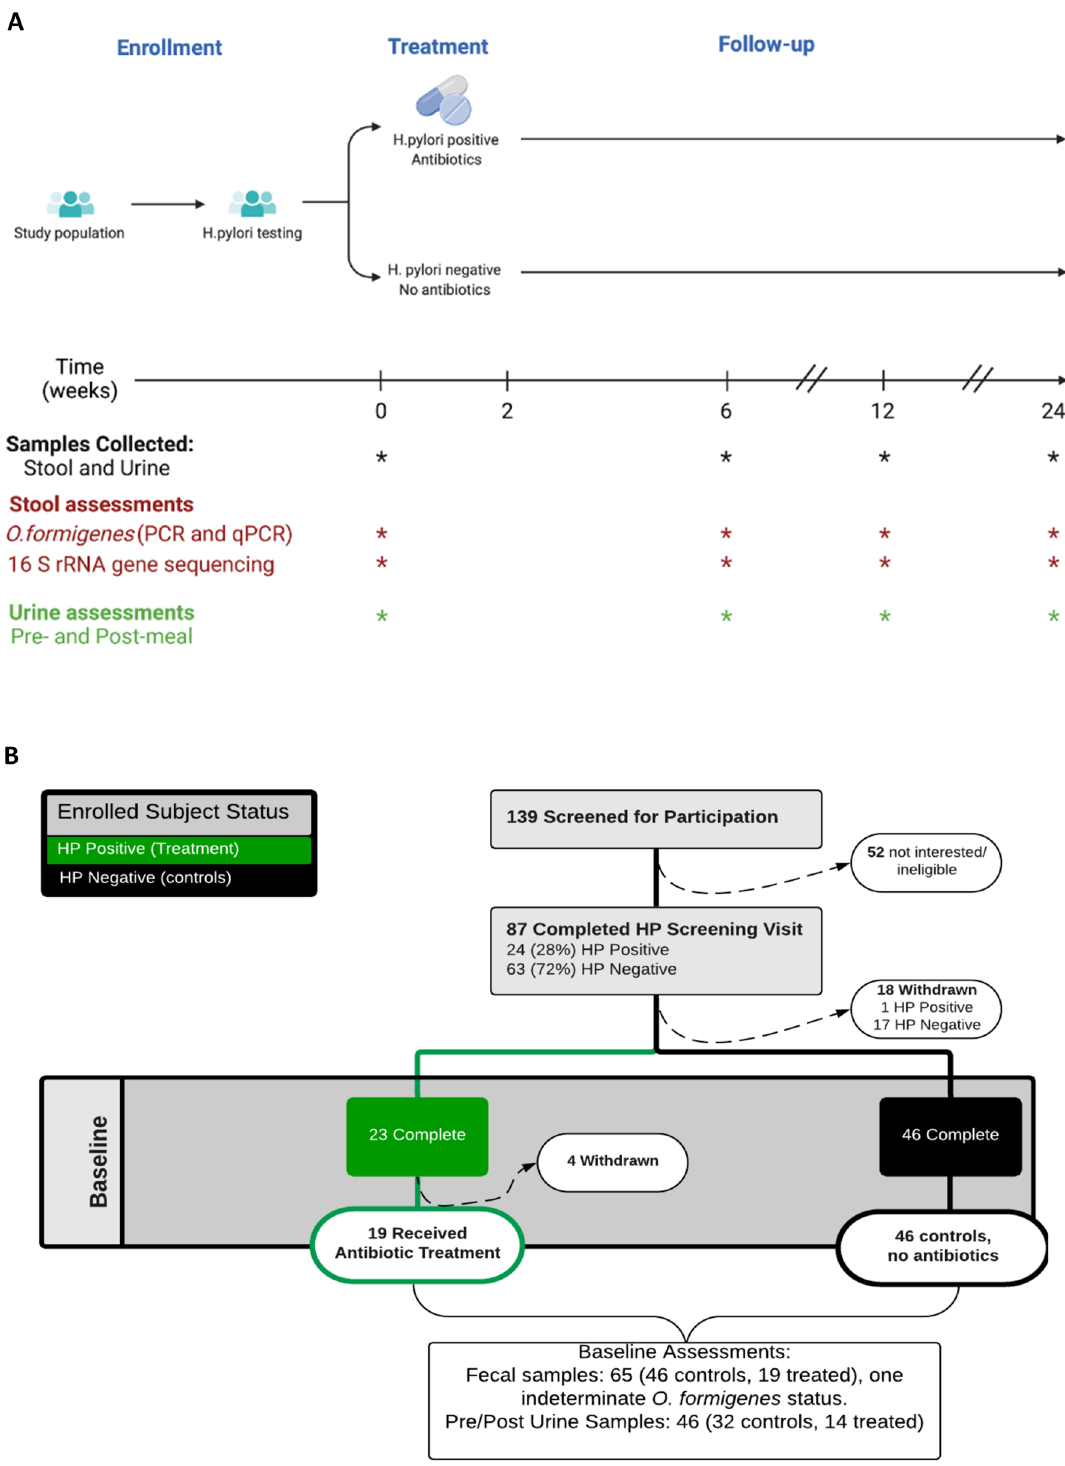
Figure 1. Study design and enrollment. Panel ( A ) Study design and assessments. From all enrolled subjects, baseline samples (stool and urine) were obtained at time 0. H. pylori- positive subjects received antibiotics for 2 weeks while H. pylori -negative subjects were followed as controls. Follow-up collections were performed at weeks 6, 12, and 24. Urine was collected after fasting (Pre-meal), and for 3 h following a standard meal (Post- meal). Stool samples were tested for O. formigenes using PCR and qPCR and underwent 16S rRNA gene sequencing. Urine was tested for multiple analytes. Panel created by BioRender software (www. biore nder. com. Panel ( B ) Enrollment. Of 139 subjects screened for participation, 87 completed the screening, and 69 subjects underwent baseline assessment. 19 H.pylori -positive subjects were treated with antibiotics ,whereas 46 H.pylori - negative subjects served as controls. Panel created by Lucidchart software (www. lucid chart.